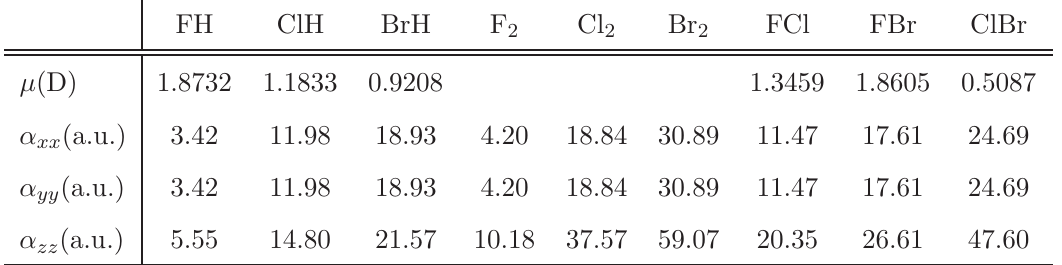
Table 7 Calculated dipole moments and static polarisability of the isolated ligands. FH ClH BrH F